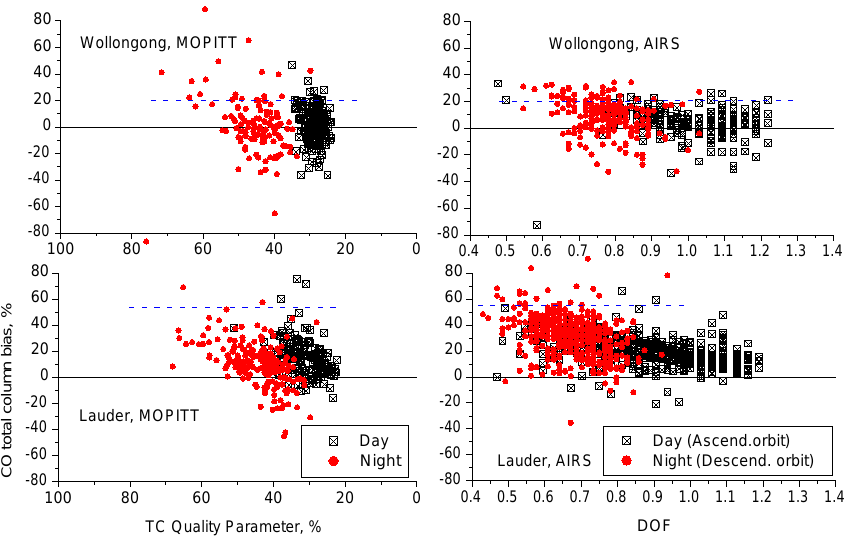
Fig. 2b. The same as Fig. 2a, but for the Southern Hemisphere.